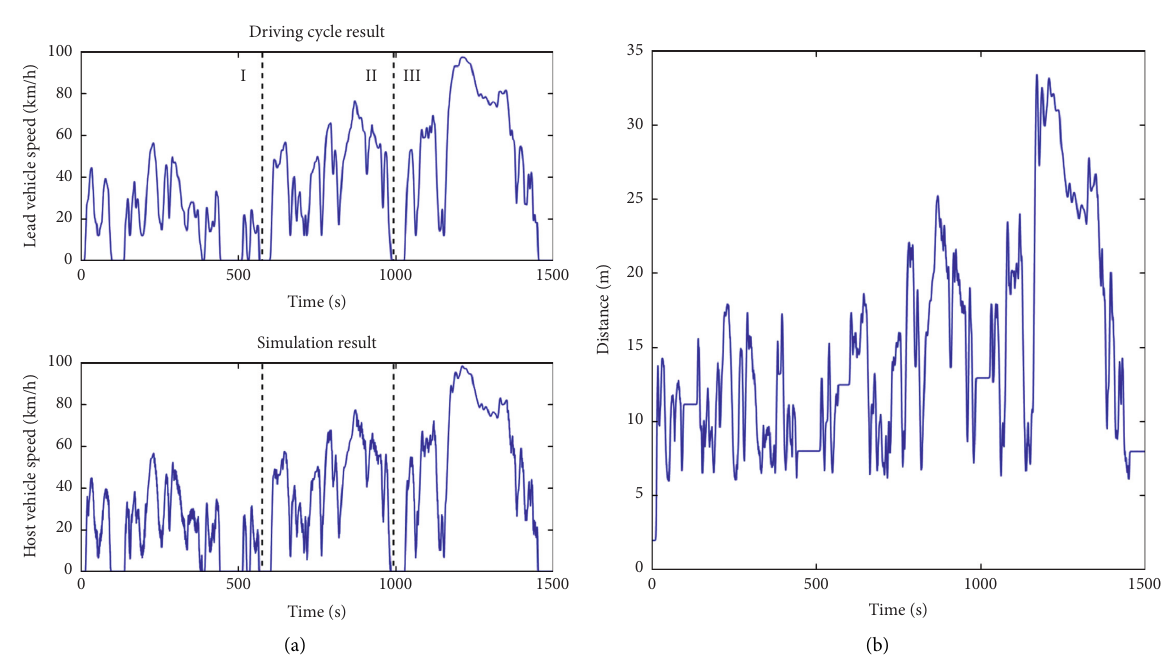
Figure 7: Simulation results of normal driver model. (a) Speed. (b) Headway